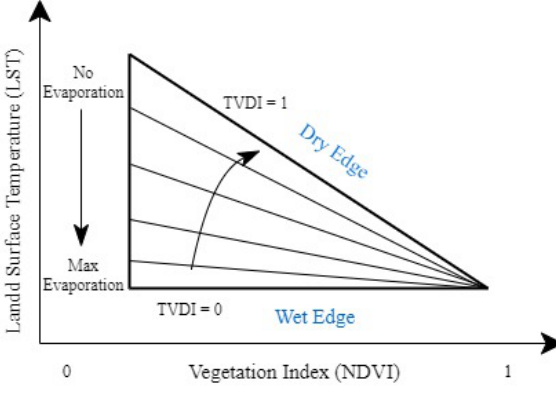
Figure 3. Simplified triangular feature